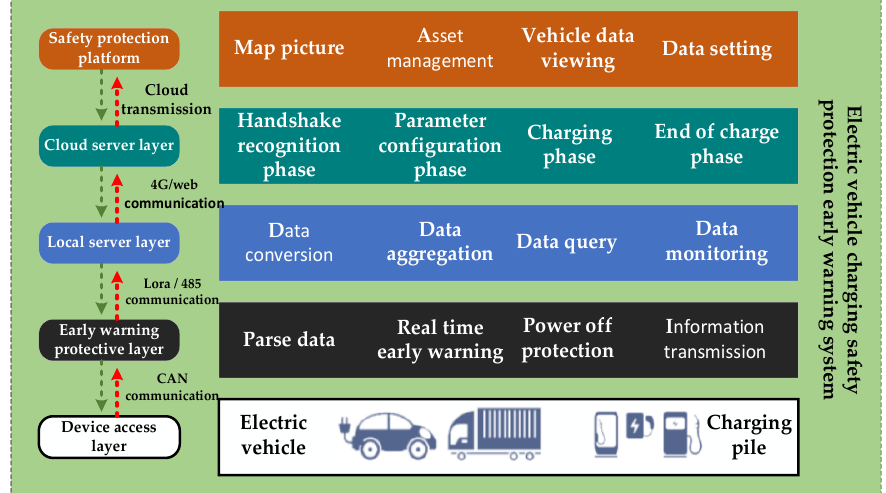
Figure 3. EV charging safety protection early warning system architecture.